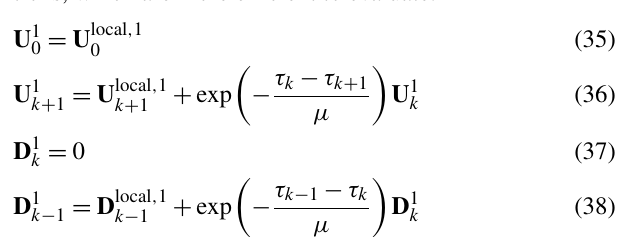
Figure 5. Illustration of the principle of the LABOS method, showing the local upward scattering radiation fields at level k . The index k = 0 ,..,K indicates the level, where k = 0 is the surface and k = K is the top of the atmosphere. The layer number refers to the upper level of the layer, and thus layer k is located between levels k − 1 and k .